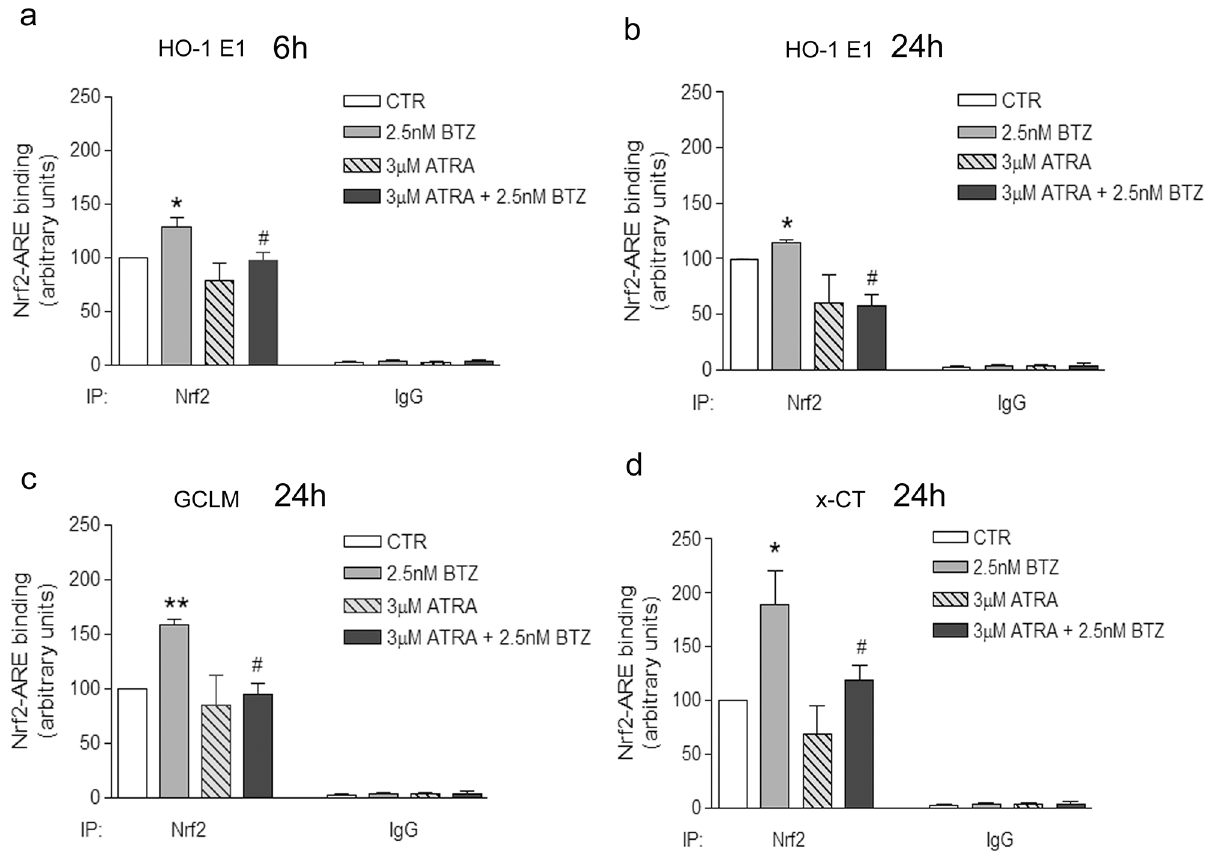
Fig 4. ATRA decreases the binding of Nrf2 to ARE sequences in the promoter regions of HO-1, GCLM and x-CT in BTZ-treated cells. The binding of Nrf2 to ARE was evaluated by means of ChIP in HTLA-230 cells treated with 2.5 nM BTZ, 3 μ M ATRA and 3 μ M ATRA + 2.5 nM BTZ. Chromatin was immunoprecipitated with anti Nrf2 or with Normal IgG antibody, as indicated. PCRs were done with primers designed for the promoter regions of HO-1 E1 enhancer (in a and b, after 6 h or 24 h of cell treatment respectively), GCLM (in c, after 24 h) and x-CT (in d, after 24 h), as detailed in Material and Methods section. The amplification of pre-cleared DNA (input) has been done to perform the normalization of results. The graphs show the mean value of three independent experiments (mean ± SE); * p < 0.05 and ** p < 0.01 vs CTR cells; #p < 0.05 vs BTZ-treated cells.